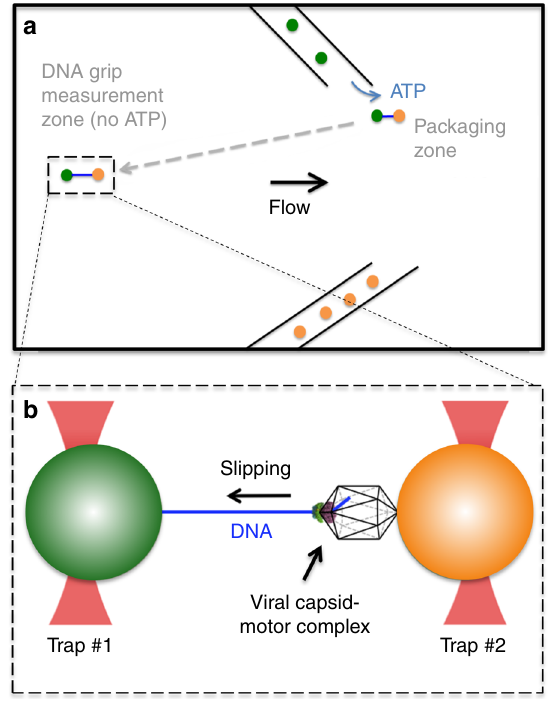
Fig. 1 Schematic illustration of the experiment. a Microspheres coated with capsid-motor complexes (orange) are dispensed by a micro-capillary tube into a fl uid chamber. One of these microspheres is trapped by an optical tweezer beam and is brought near a second micro-capillary tube that is dispensing ATP and microspheres coated with DNA (green). b One of these DNA microspheres is trapped with a second tweezer beam and brought near the capsid-motor complexes to initiate packaging. After ~4 – 7 kbp of DNA (blue) is packaged the complex is rapidly moved out of ATP (away from the micro-capillary tube, as shown by the dashed arrow) and into a region of the chamber (the “ grip measurement zone ” ) containing either no nucleotides, γ -S-ATP, or ADP. A small stretching force (3 – 5 pN) is applied to the DNA while the motor ’ s grip is monitored